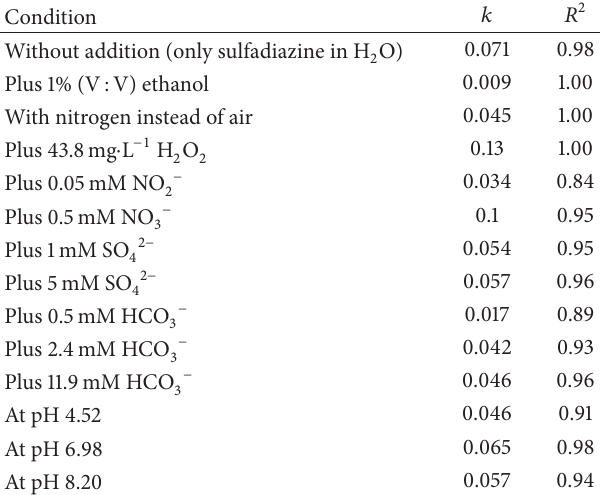
Table 1: First-order kinetic constants 𝑘 of sulfadiazine photodegra- dation in ultrapure water irradiated by UV light of 365 nm and 300 W with air pumping in (except the condition of N 2 instead) under various